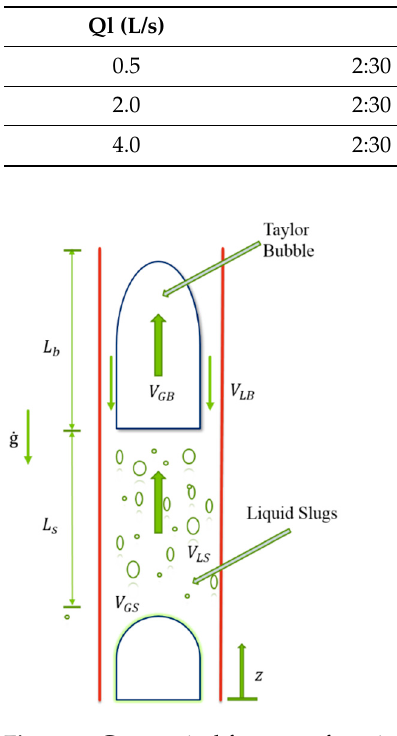
Figure 5. Geometrical features of an air-water slug